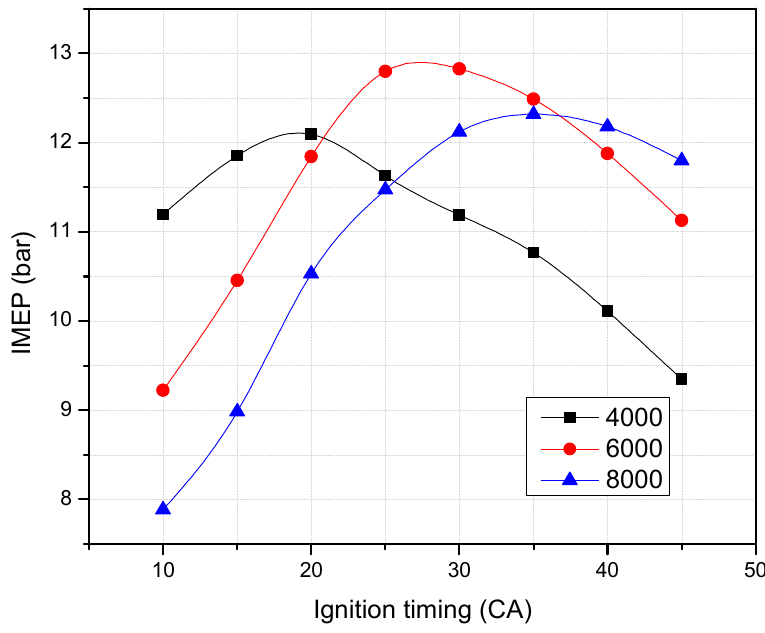
Figure 13. BMEP versus ignition timing.